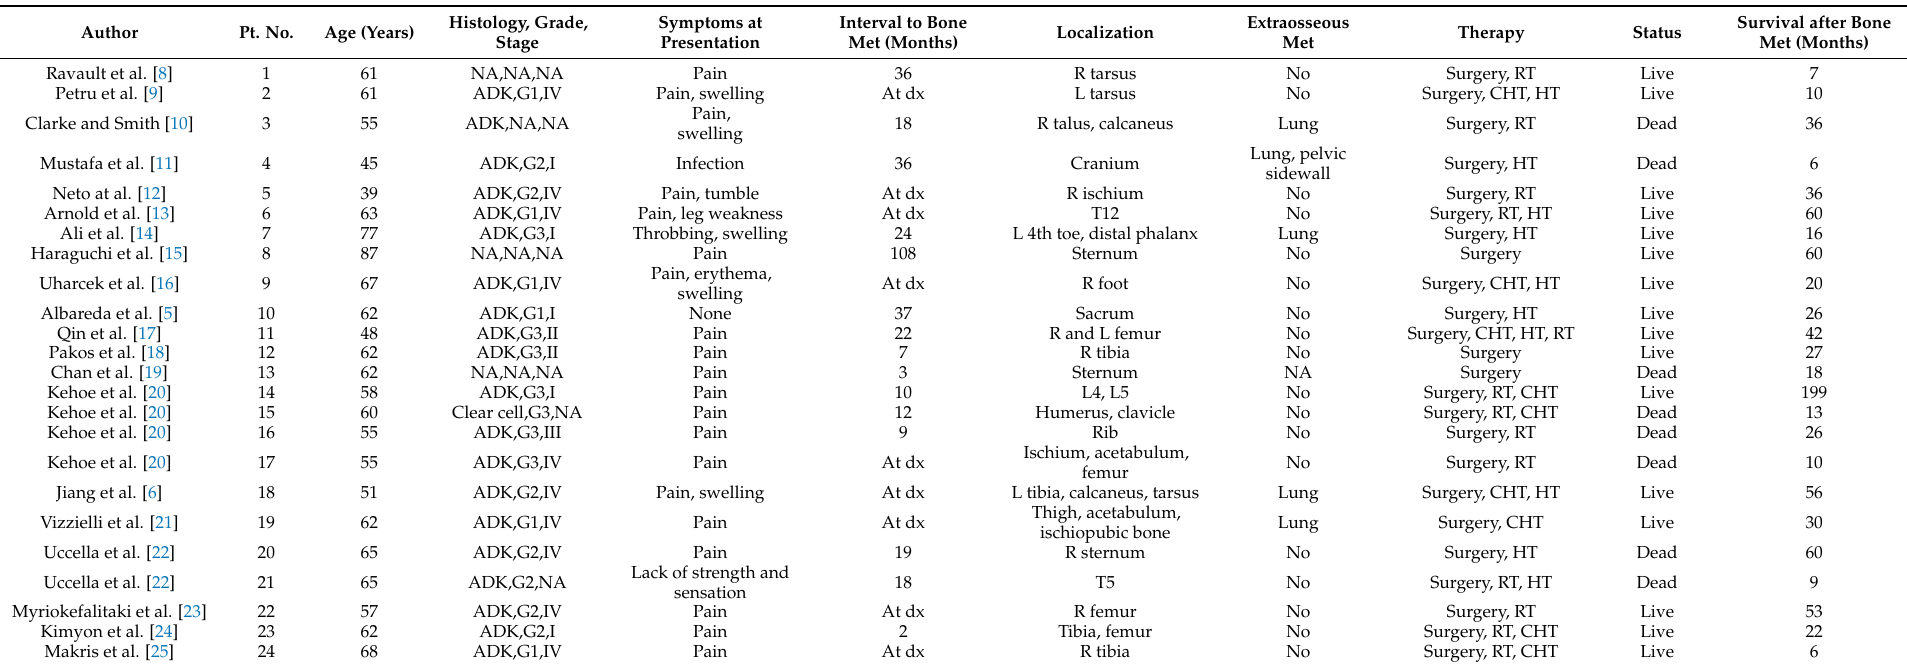
Table 2. Characteristics of 24 patients with primary bone metastases of EC treated by surgery reported in the